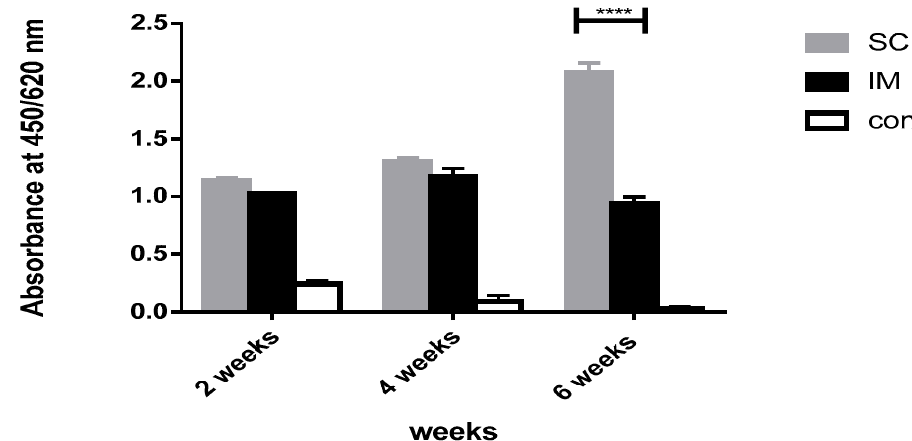
Figure 7. Immune response of SC route of BG vaccine versus IM route of the commercial vaccine. A bar chart showing antibody response in rats measured in terms of absorbance values in weeks 2, 4, and 6 after immunization with BG (SC) and commercial meningococcal vaccine (IM). Error bars represent the standard deviation from the mean. **** indicates significance with p < 0.0001.